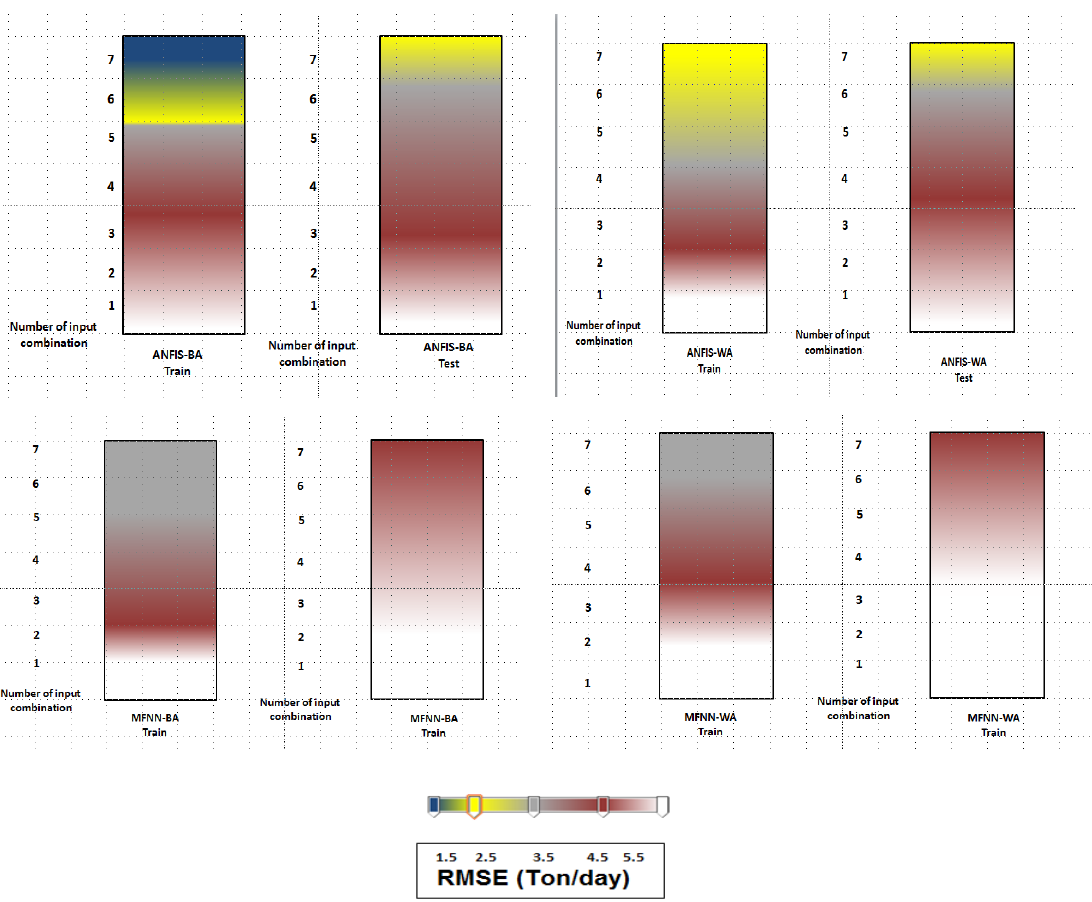
Figure 10. RMSE computations for different combinations.